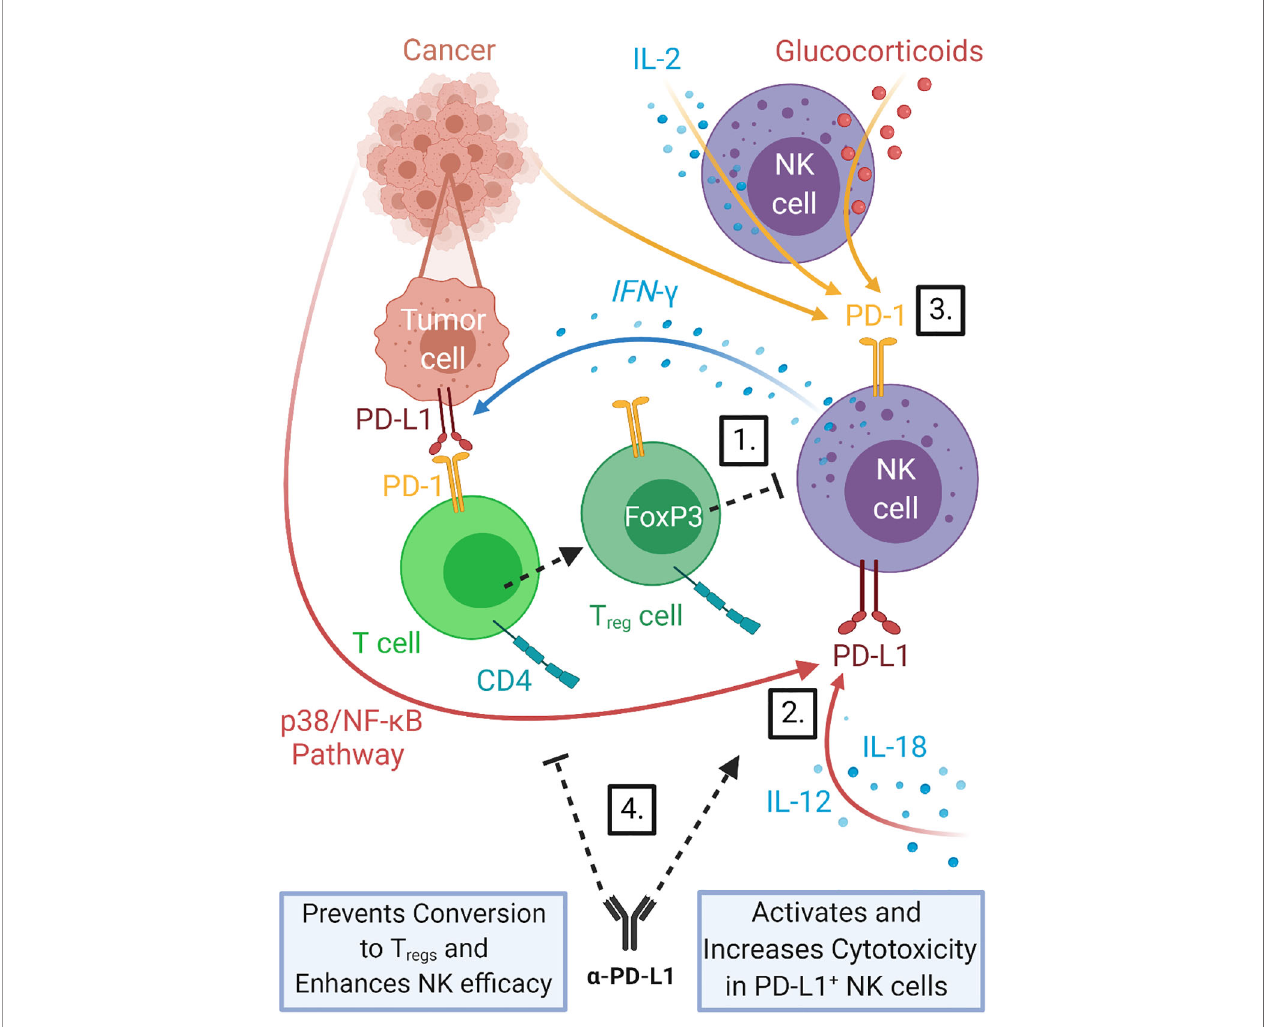
FIGURE 2 | NK cells interact with the PD-1/PD-L1 immune checkpoint axis. NK cells can increase the expression of PD-L1 on tumor cells through release of cytokines such as IFN - g , promoting PD-1/PD-L1 driven stimulation of Treg production which in turn can inhibit NK cell function. 1) NK cells have also been shown to express both PD-L1 and PD-1 themselves. PD-L1 expression can be induced in NK cells by direct interaction with tumor cells via the p38/NF- k B pathway and by stimulation with cytokines IL-12 and IL-18 (25). 2) PD-1 expression in NK cells has been shown to be upregulated in a variety of cancers (26, 60, 61) and to be inducible in response to IL-2 stimulation (60) and glucocorticoid signaling (62). 3) Treatment with PD-1/PD-L1 blockade therapy can help prevent Treg inhibition of NK cells and counteract PD-1/PD-L1 driven NK cell dysfunction. 4) PD-L1 expression on tumors correlates with response to PD-1/PD-L1 checkpoint blockade therapies, thus induction of PD-L1 by NK cells should improve outcomes of this